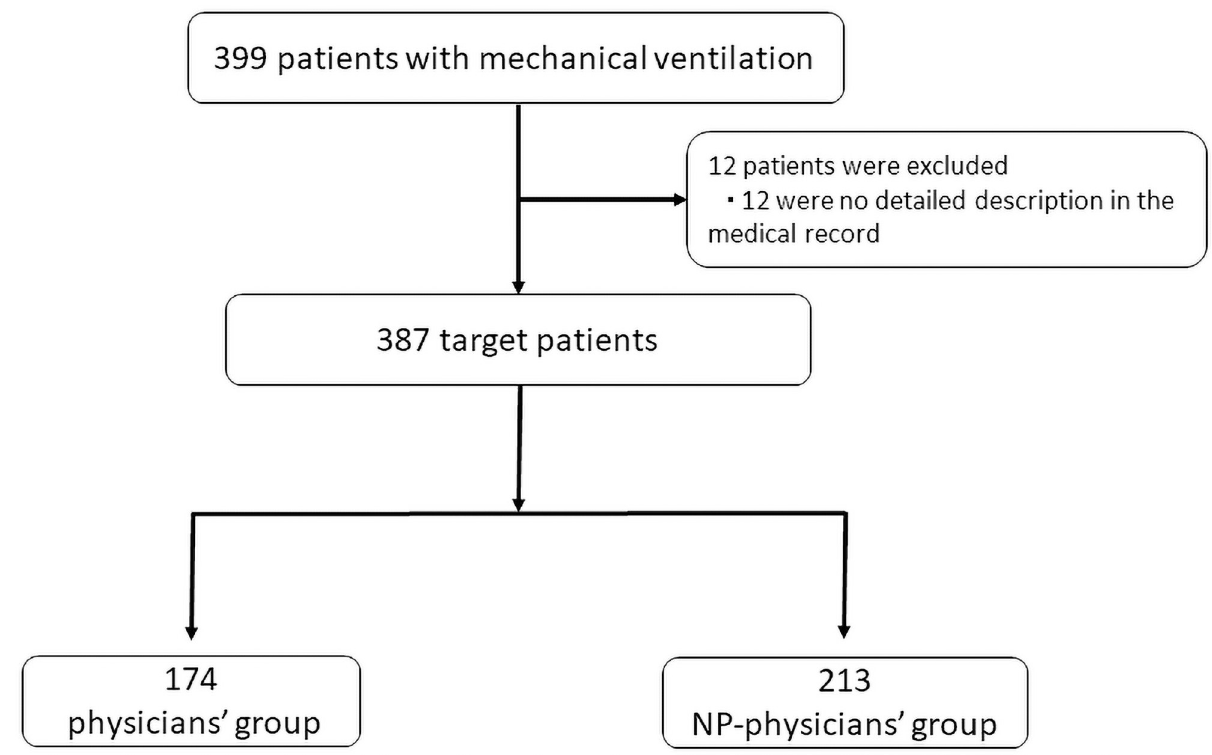
Fig 1. Derivation of the study cohort. All mechanically-ventilated postoperative patient admissions to the physicians group and NP–physicians group were included in the analysis where data were available.